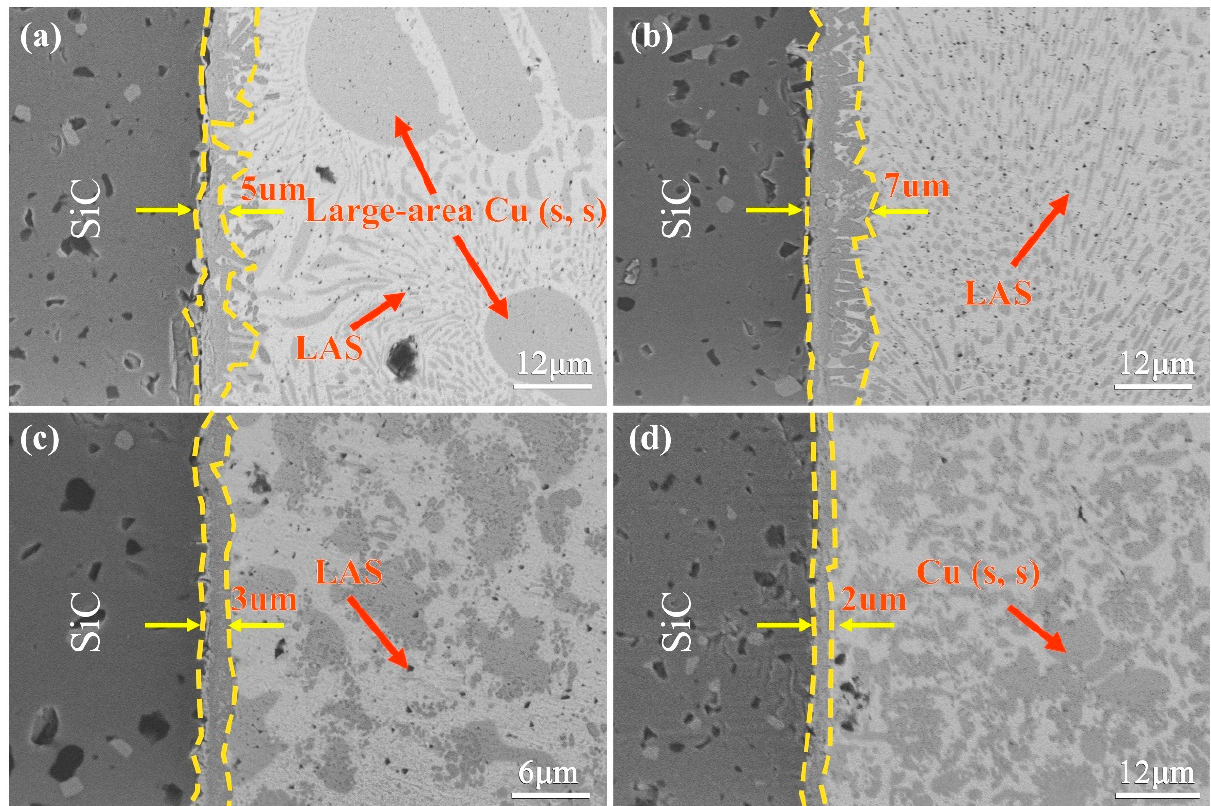
Figure 10. Local enlargement of typical interfaces of AgCuTi + 1 wt% LiAlSiO 4 brazed SiC joints with different holding times at 900 °C; ( a – d ) holding times 5 min, 10 min, 15 min, and 20 min.